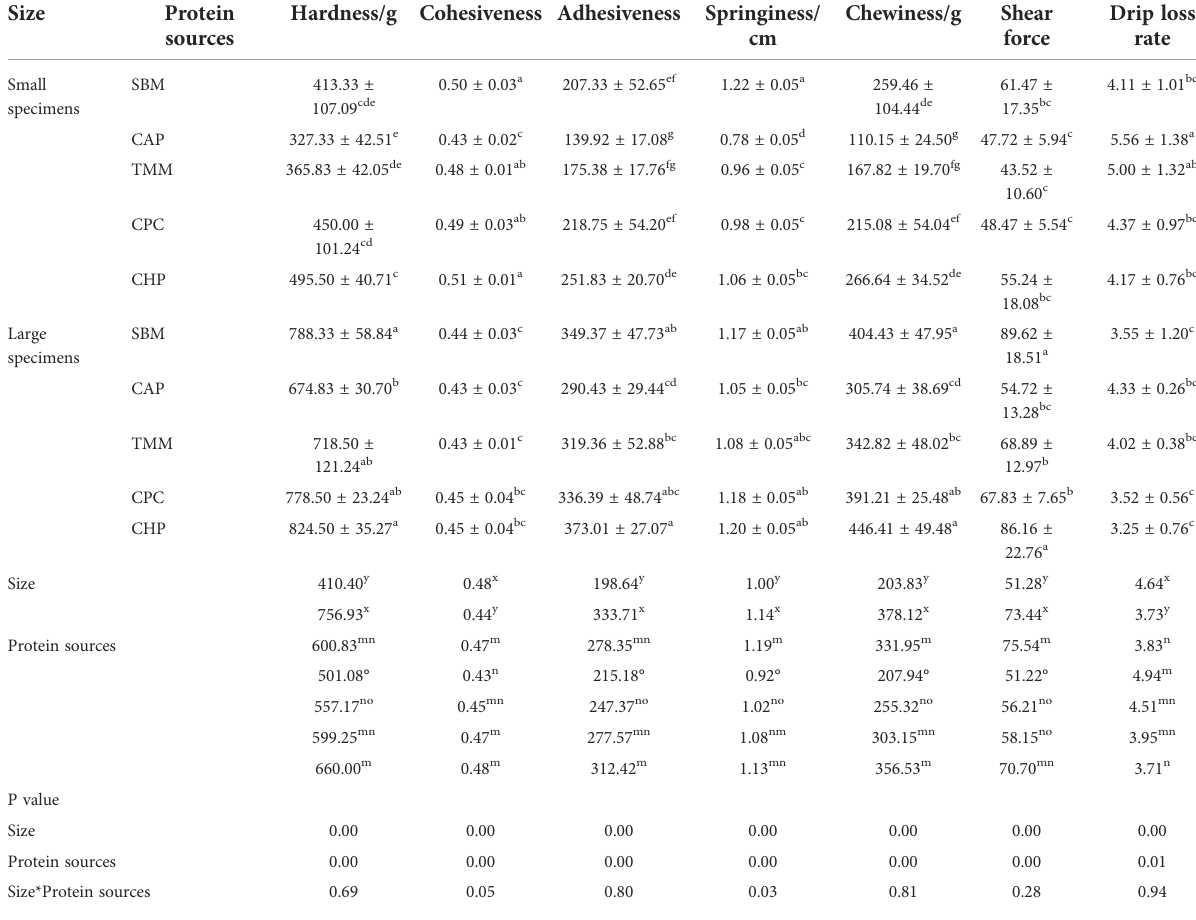
TABLE 6 Muscle texture, shear force, and drip loss in different